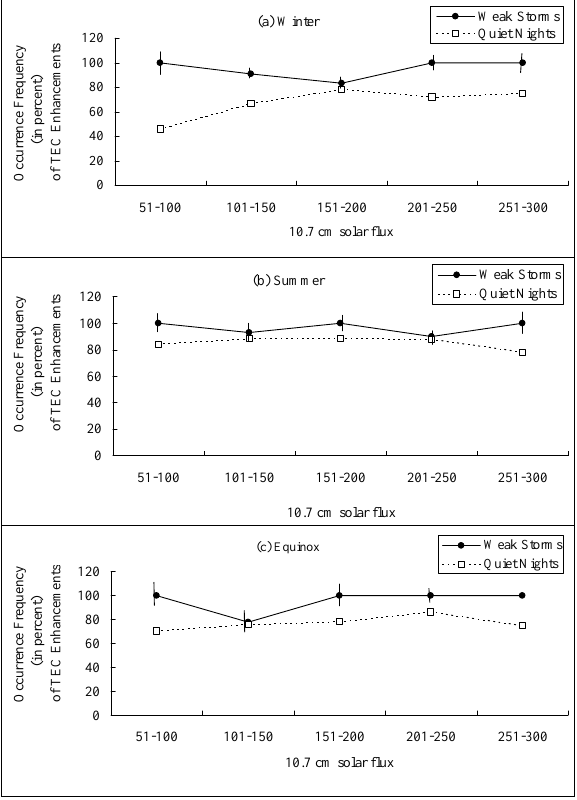
Fig. 3. The seasonal and solar activity variations of the mean half- amplitude duration during weak storms (solid curves) and quiet nights (dashed curves). The vertical bars represent the standard de- viations.